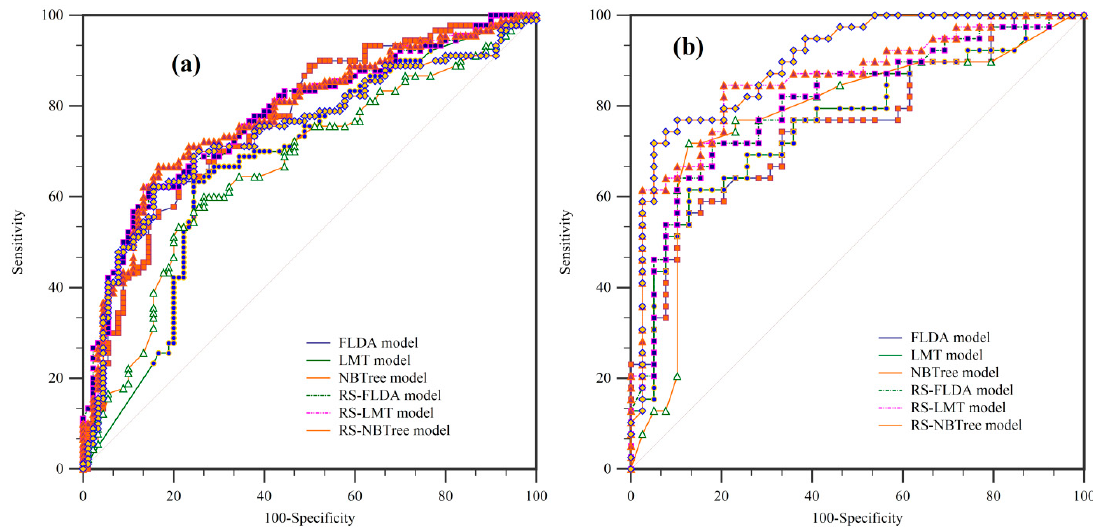
Figure 6. Validation of results. ( a ) Success rate curve and ( b ) prediction rate curve.